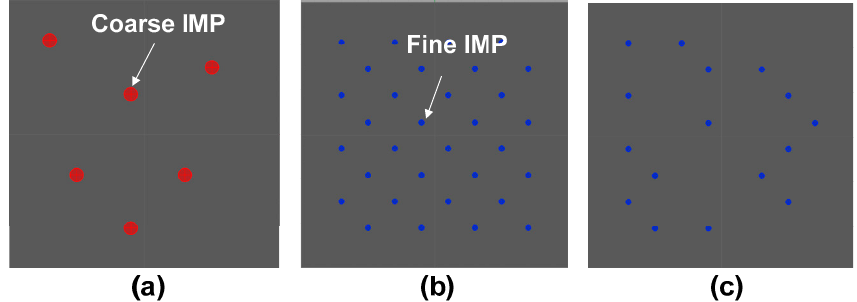
Figure 2. IMPs distributed models for corrosion simulation: ( a ) large size of IMPs in the Al matrix (large IMPs area); ( b ) small size of IMPs in the Al matrix (large IMPs area); and ( c ) small size of IMPs in Al matrix (small IMPs area). Table 3. Polarization parameters of IMPs and the Al matrix used for corrosion simulation.